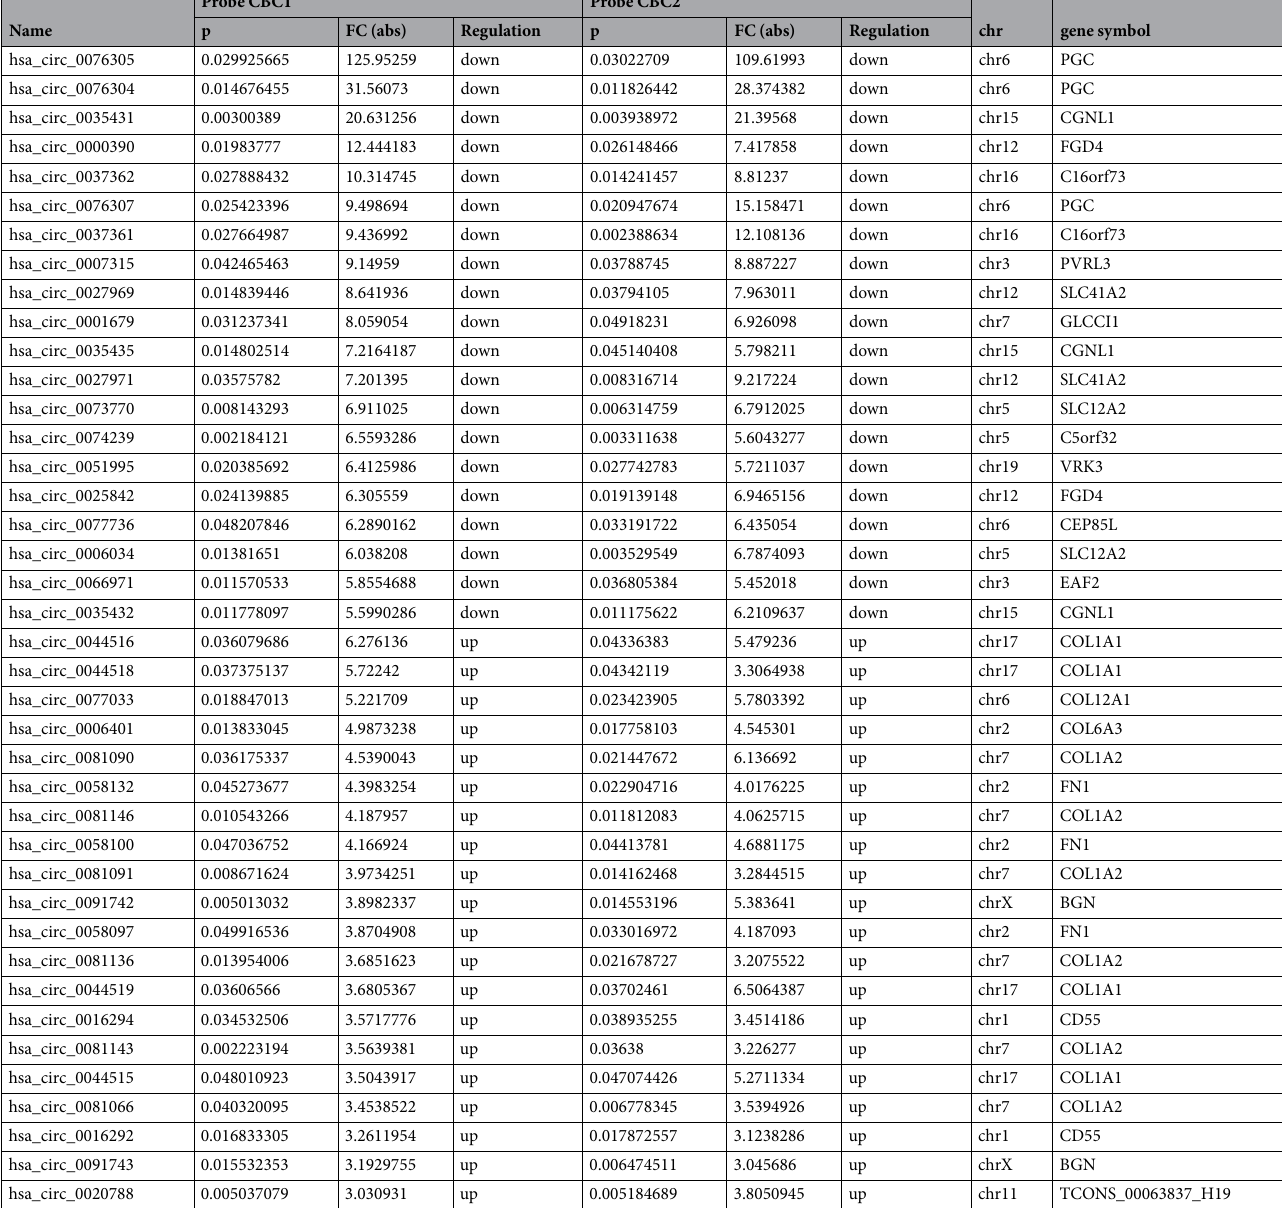
Table 2. The top up- and down-regulated differentially expressed circRNAs in GC tissues compared to those in non-cancerous tissues by both probes. FC: Fold changes. abs: absolute